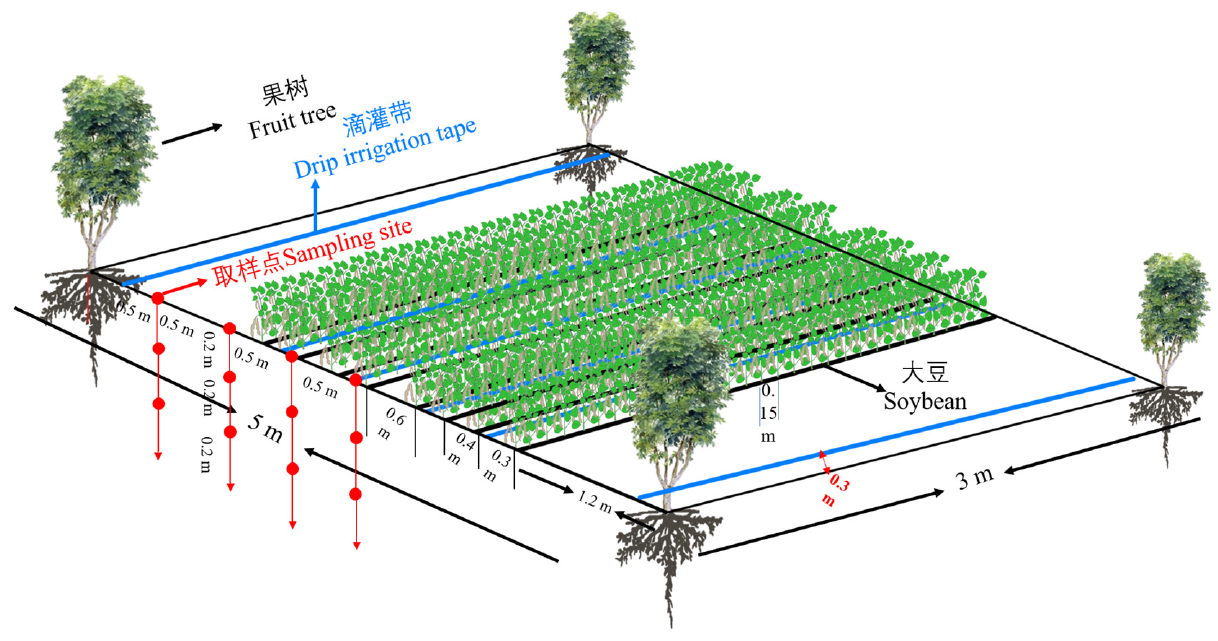
Figure 2. Diagram of a soybean–apple intercropping system.